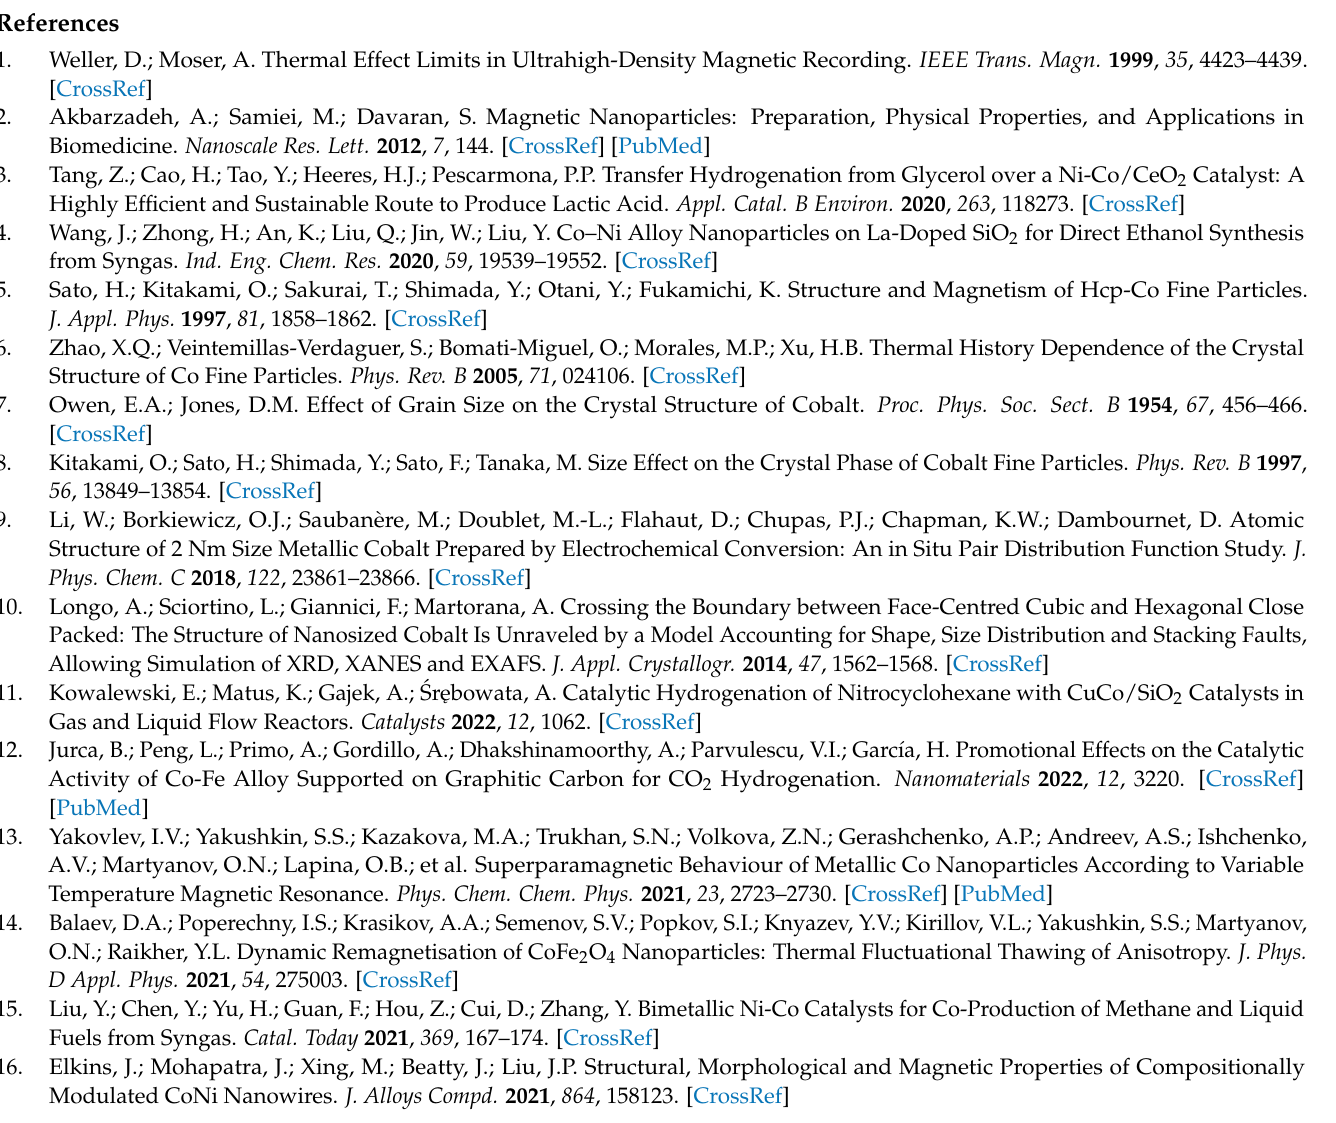
samples. Figure S7: HRTEM image of nanostructured metallic nanoparticles in the Co2Ni_W0 sample with thick (let) and thin (right) alternating domains with different